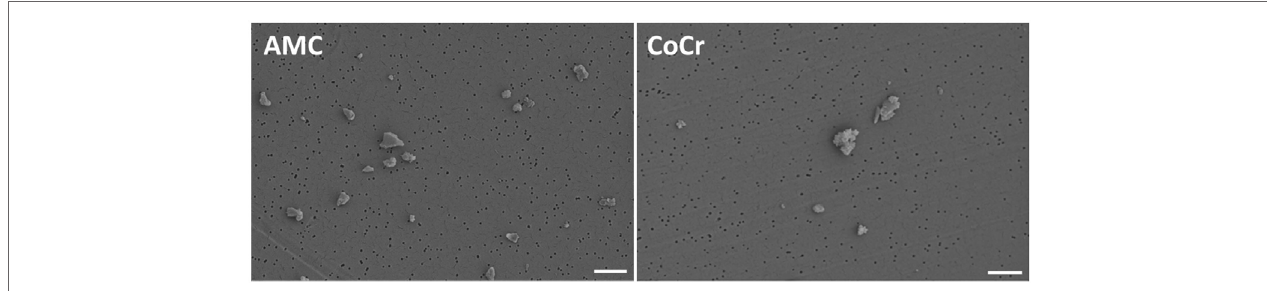
FigUre 1 | Representative FESEM pictures of AMC and CoCr particles. AMC particles showed a granular, irregular, and angulated appearance (left panel). Particles derived from a CoCr alloy revealed a flake-like to globular (cauliflowers) appearance (right panel). Bar: 1